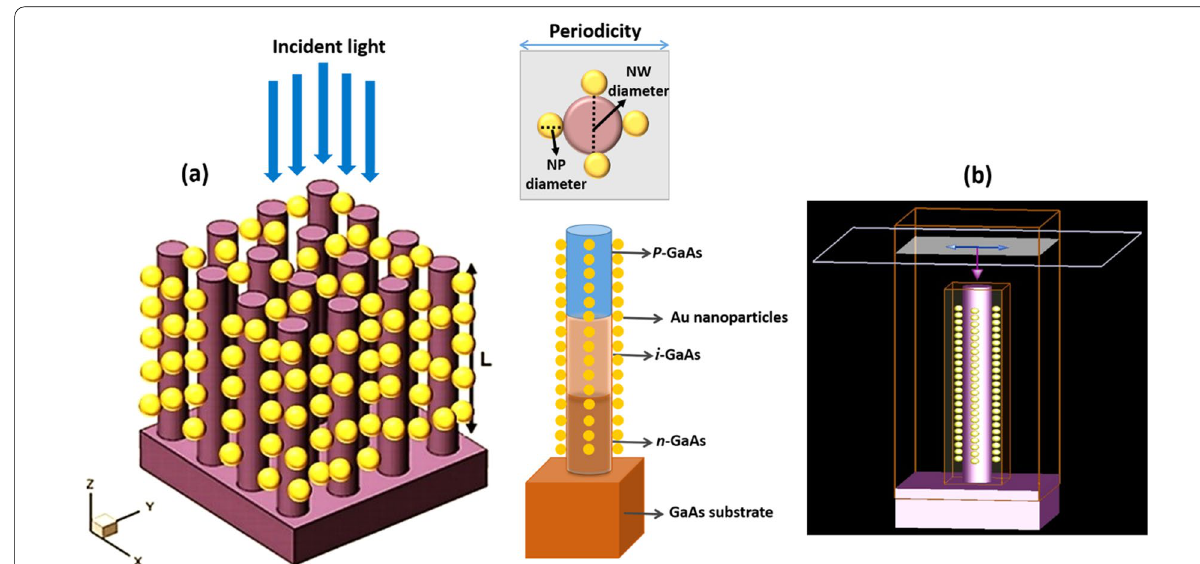
Fig. 1 a The structure of the plasmonic GaAs nanowire solar cell decorated with Au nanoparticles in 3-D and b the simulated unit structure of the plasmonic GaAs nanowire solar cell. The insets represent the top view of a single GaAs nanowire decorated with Au nanoparticles (top) and the p - i - n junction nanostructure